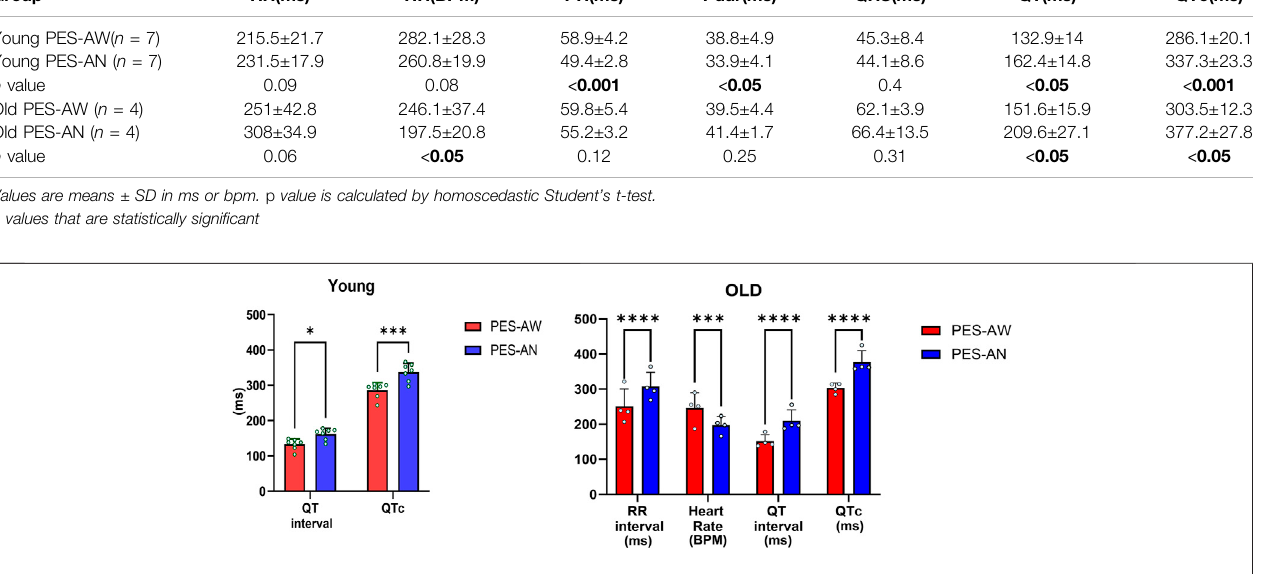
TABLE 3 | Effect of anesthesia on ECG parameters in younger and older adult guinea pigs, recorded using a platform ECG system. Group RR(ms)